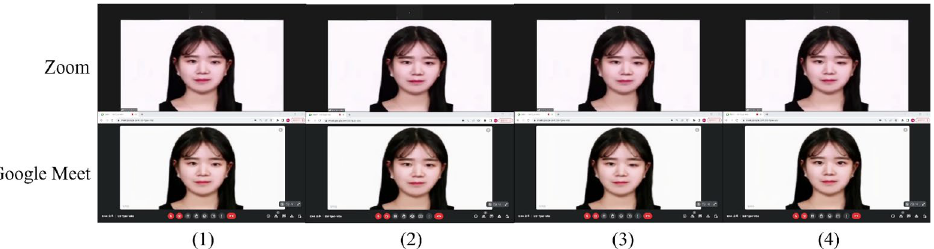
(a) Comparison between Zoom and Google Meet.